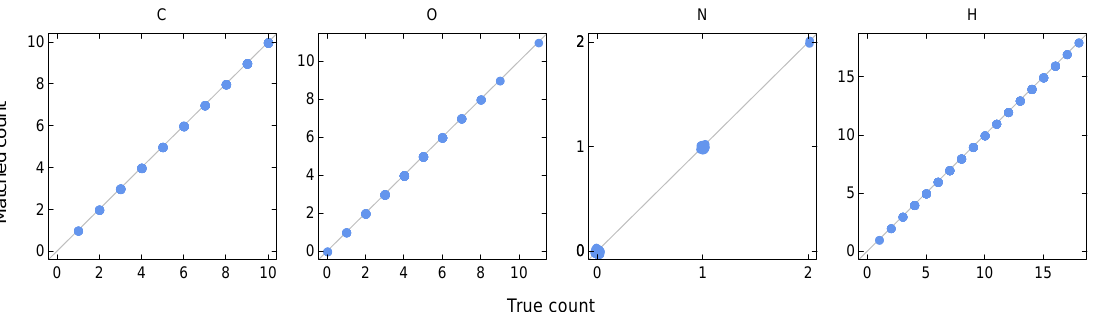
Figure 3. Test of the completeness of matching of all the atoms in the α -pinene and 1,3,5-trimethylbenzene degradation scheme in MCMv3.2 by the SMARTS patterns in Table 1, substructures